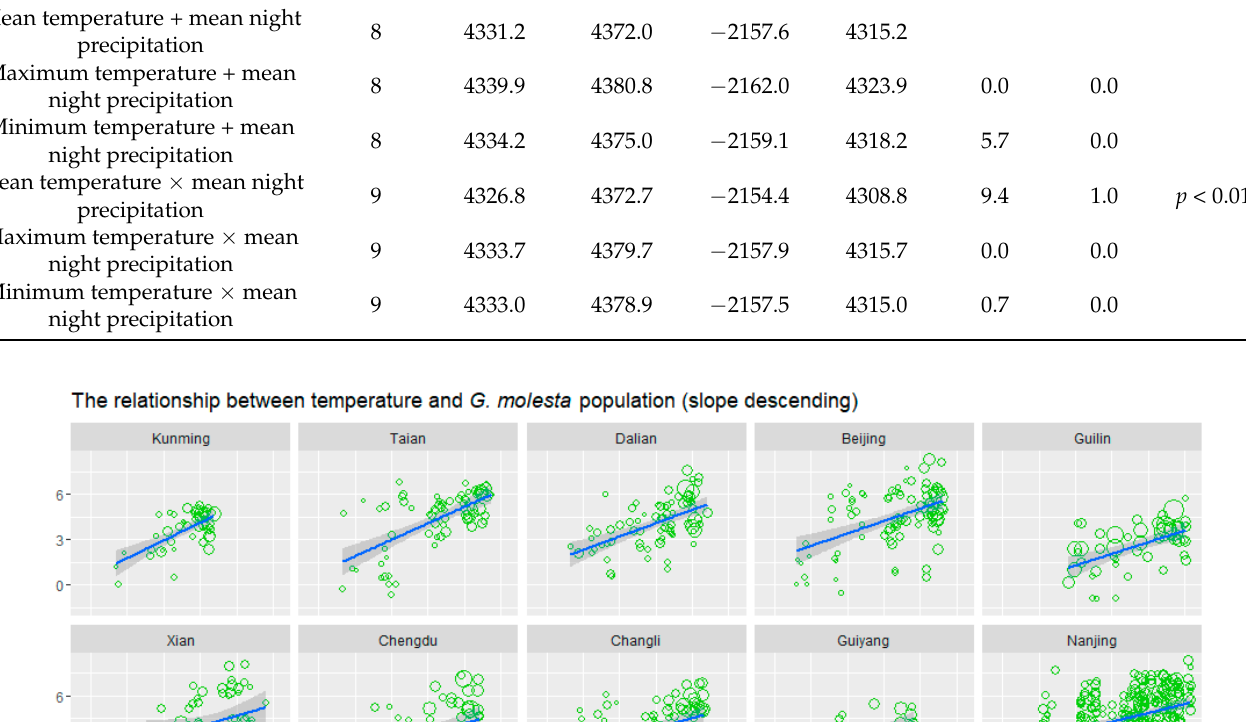
Table 3. The models with two predictors and interaction compared with the models without it.